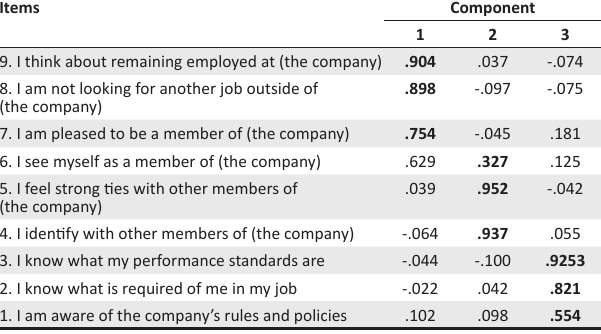
TABLE 2: Pattern matrix after removing cross-loading item.